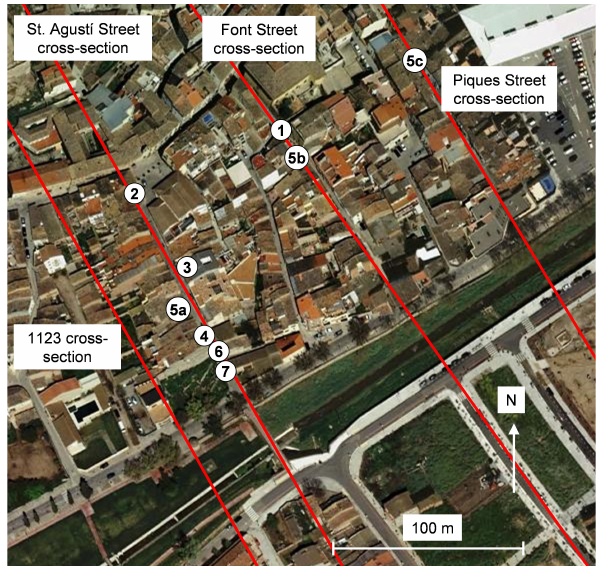
Fig. 6. Location of the nine observed maximum water heights of the seven studied floods, obtained from historical information (a key can be found in Table 1); and the four reference cross-sections used when comparing observed and modelled water heights.